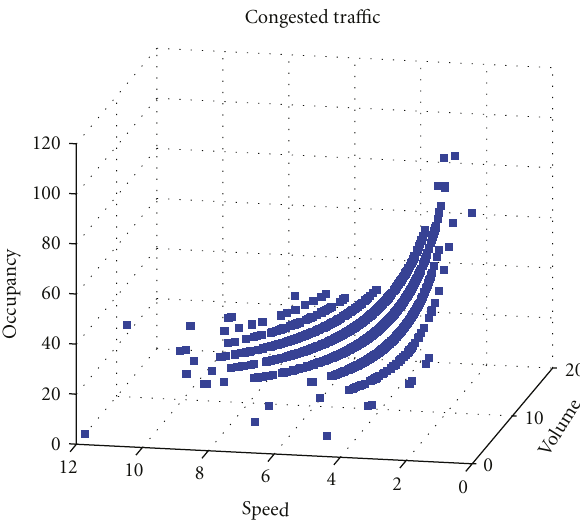
Figure 4: An example simulator data for Congested tra ffi c.